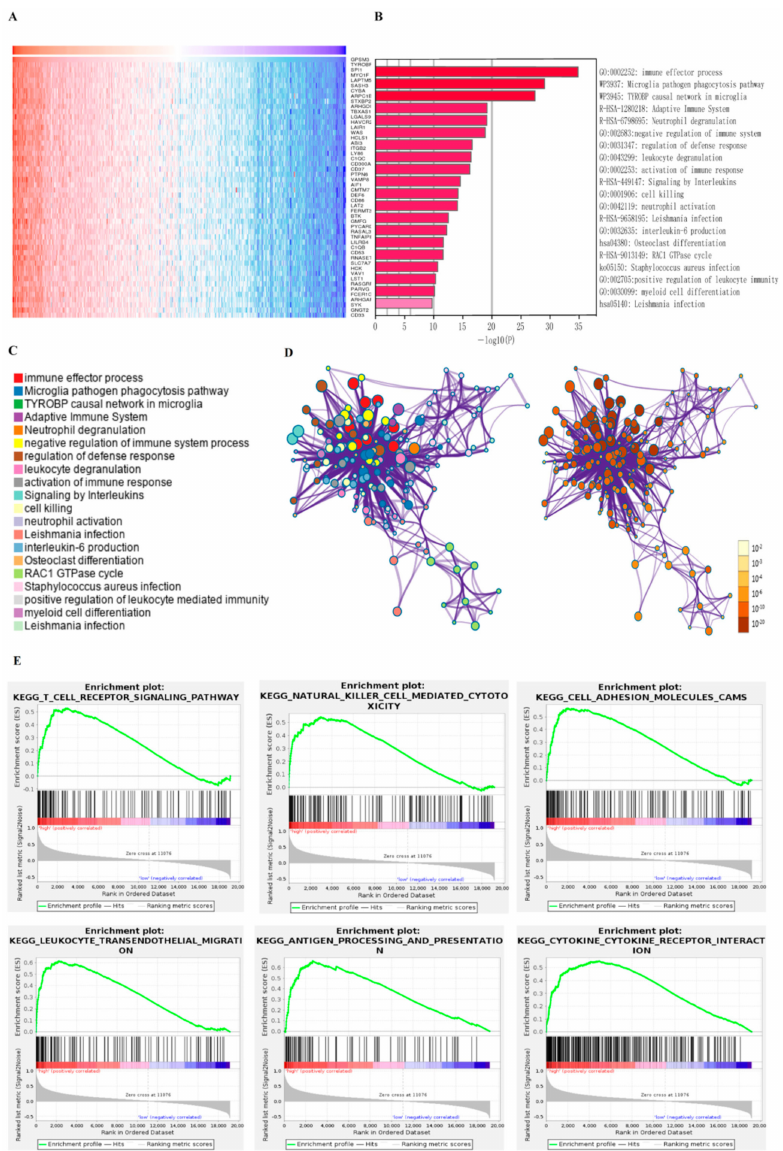
Figure 3. The function analysis of GPSM3 in LGG patients. ( A ) Heatmap of GPSM3 top 50 positively correlated genes. ( B ) Bar graph showing the enriched terms of GPSM3 positively correlated genes. The color depth denoted the p -value. ( C , D ) Network plot of enriched terms: ( C ) each node represented one enriched term colored by its cluster ID; ( D ) colored by p -value. ( E ) GSEA enrichment analysis of GPSM3 high expression group in TCGA dataset, p -value < 0.05 was considered statistically